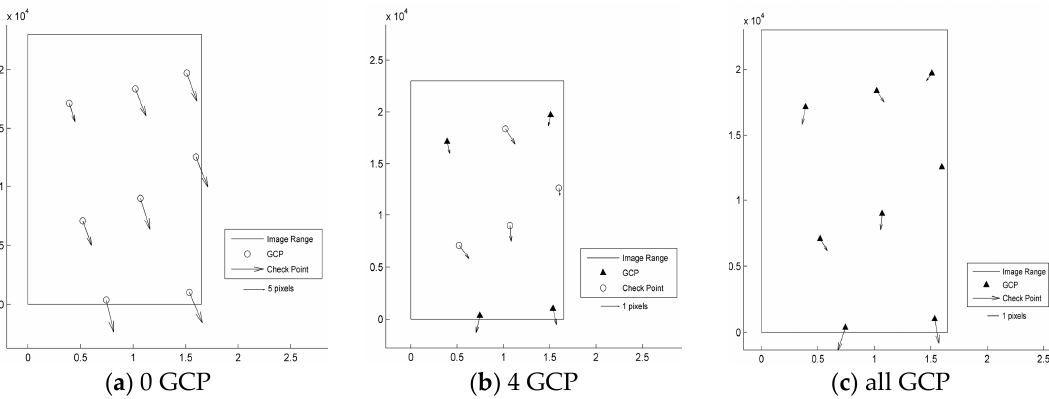
Figure 4. Residual distributions of check points of the UFS mode orientation for Tianjin: ( a ) 0 GCP; ( b ) 4 GCP; ( c ) all GCP.